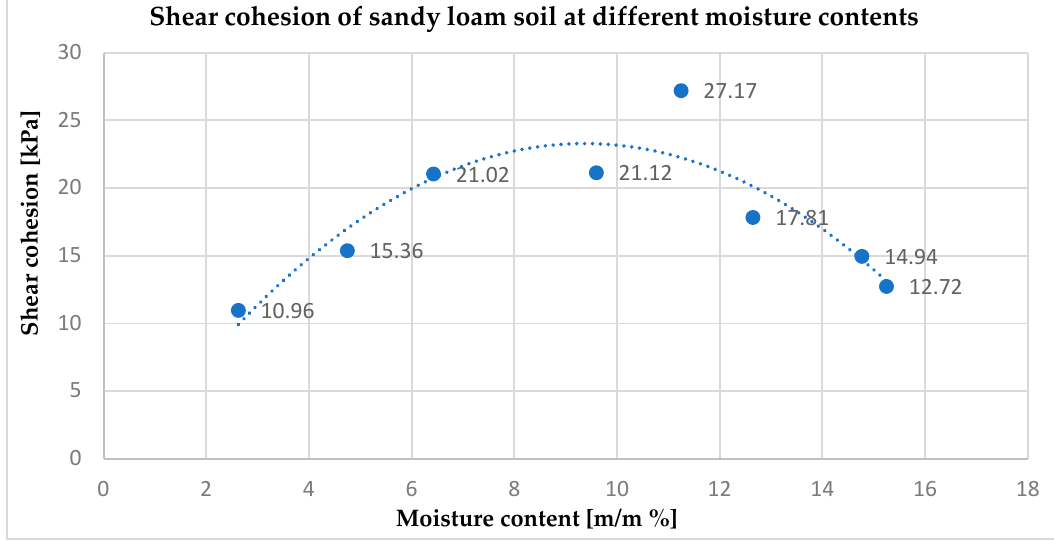
Figure 5. Sandy loam soil shear cohesion at different moisture contents .